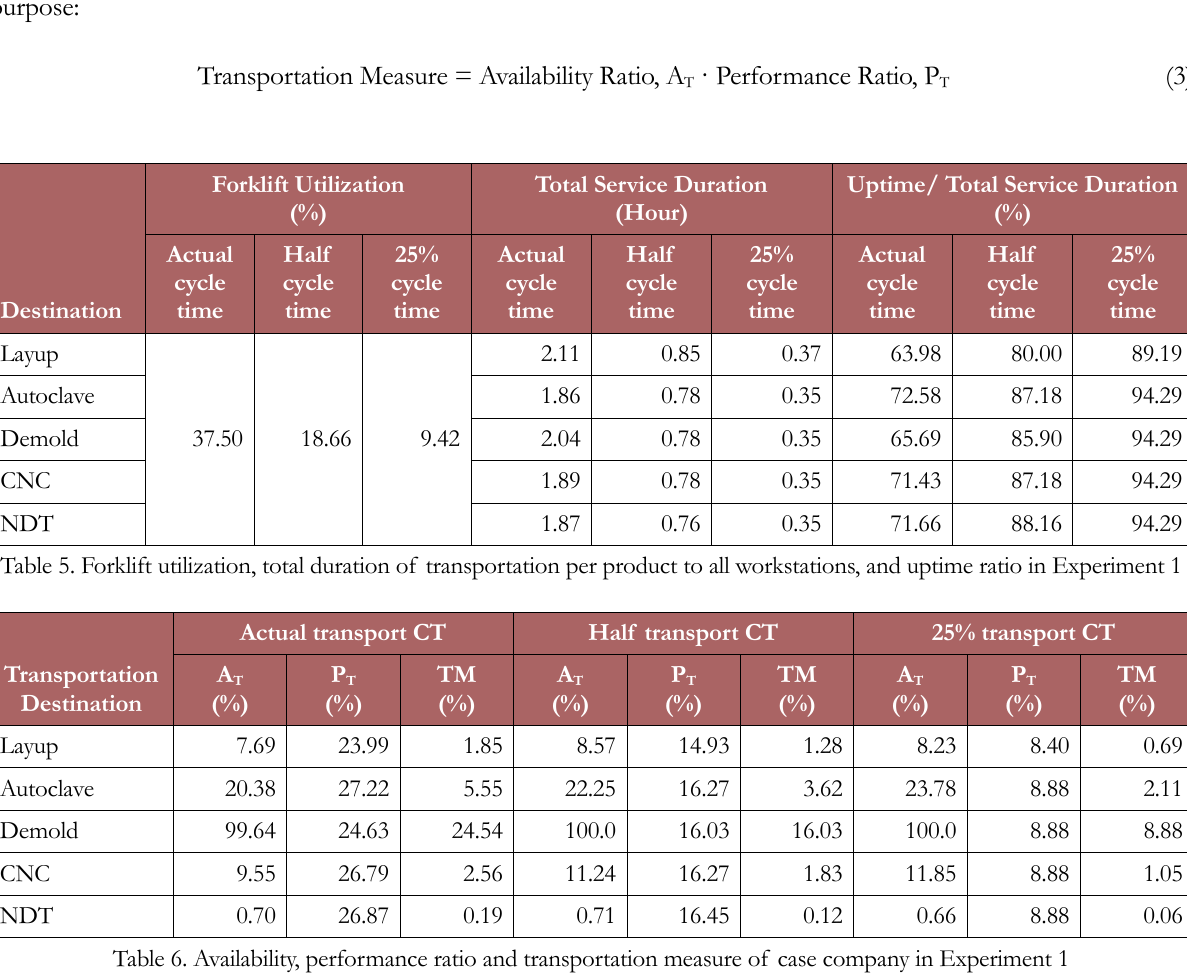
Table 6. Availability, performance ratio and transportation measure of case company in Experiment